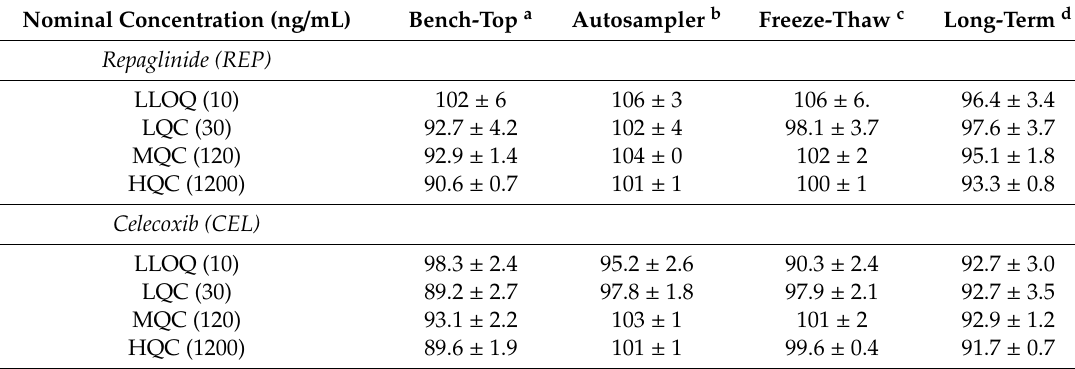
Table 3. Stability (%) of REP and CEL in rat plasma ( n =